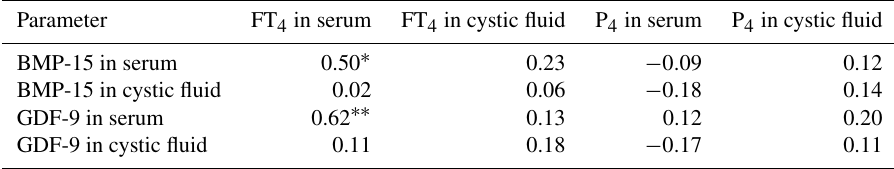
Values marked ∗ and ∗∗ are significant at p < 0 . 05 and p < 0 . 01